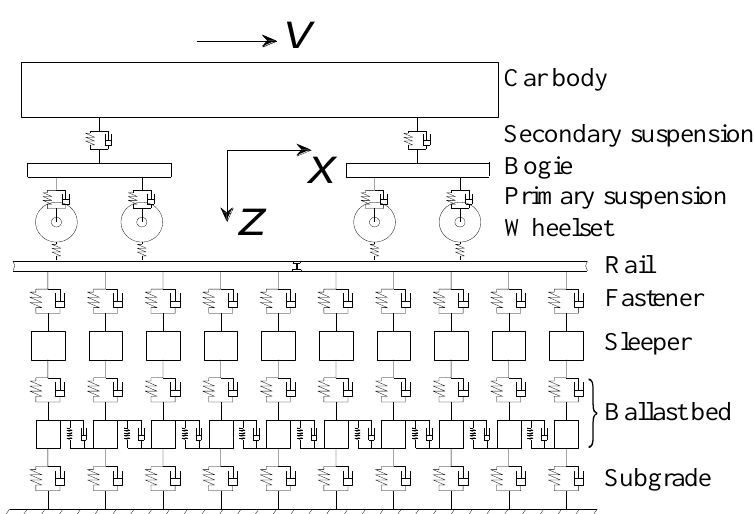
Figure 3. Vehicle–track dynamic coupling model. Figure 3. Vehicle – track dynamic coupling model.